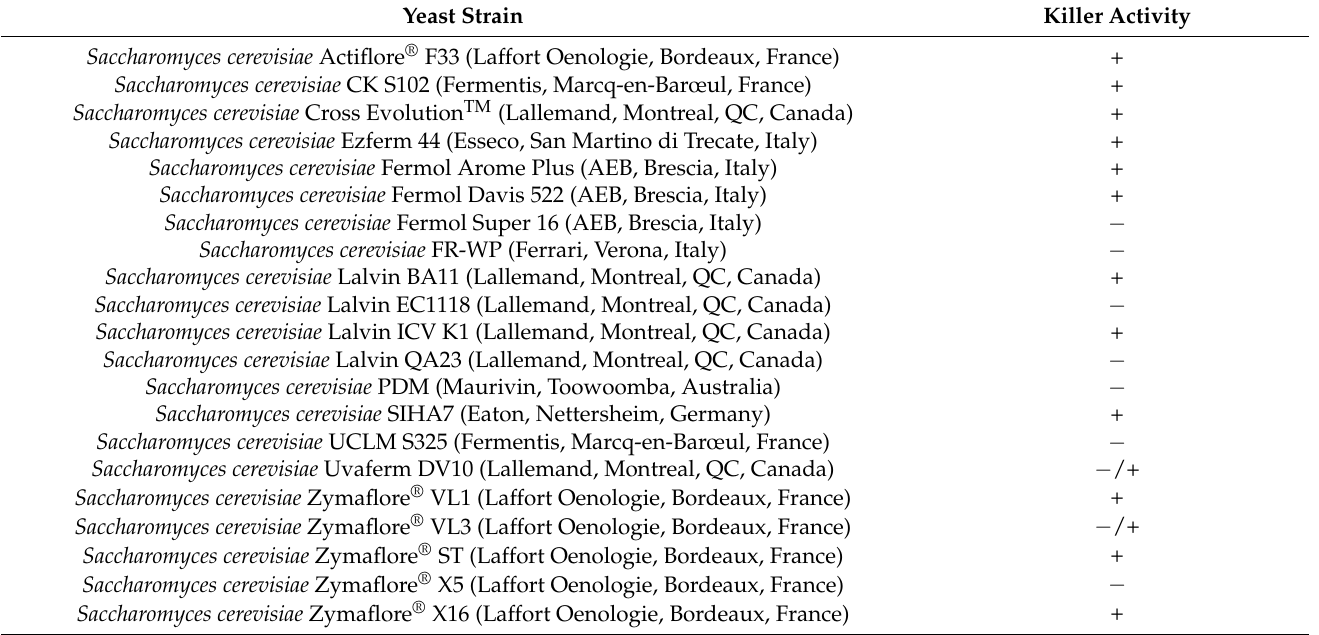
Table 1. Killer activity of the strain Kluyveromyces marxianus Km L2009 against commercial yeast strains. Yeast Strain Killer Activity